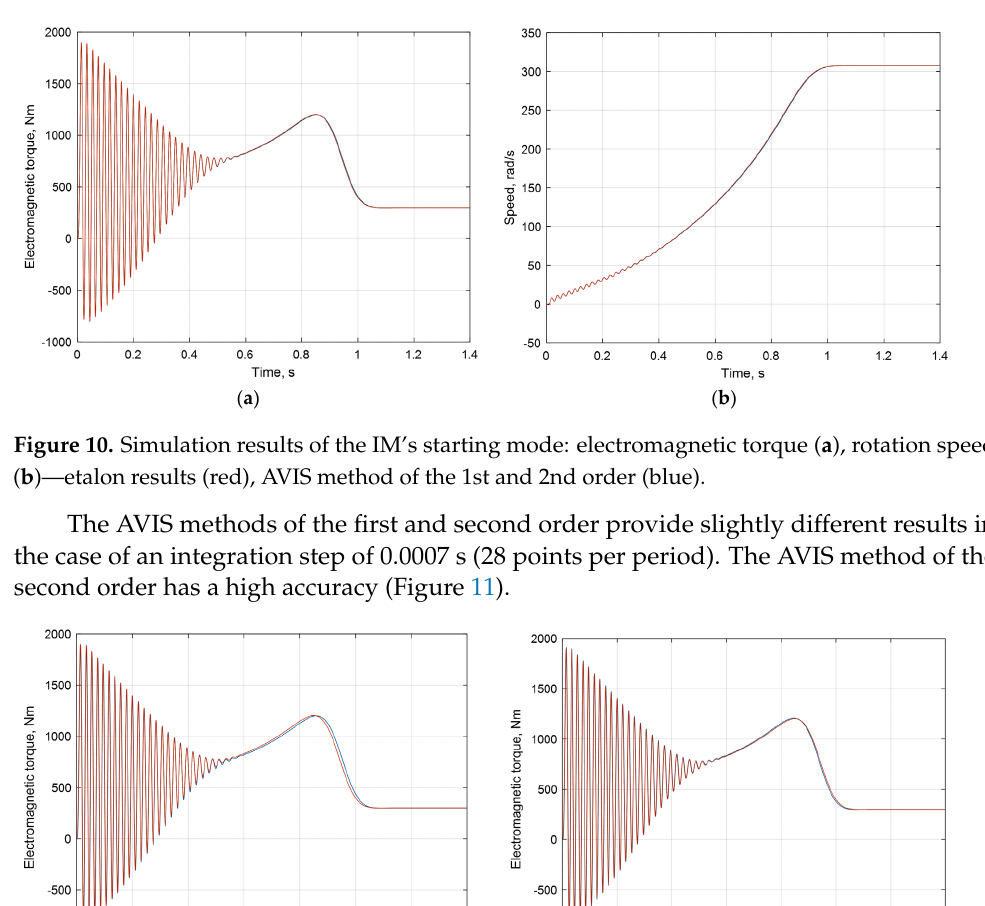
Figure 9. Simulation results of the IM’s starting mode: stator current ( a ), rotor current ( b )—etalon results (red), AVIS method of the 1st and 2nd order (blue).